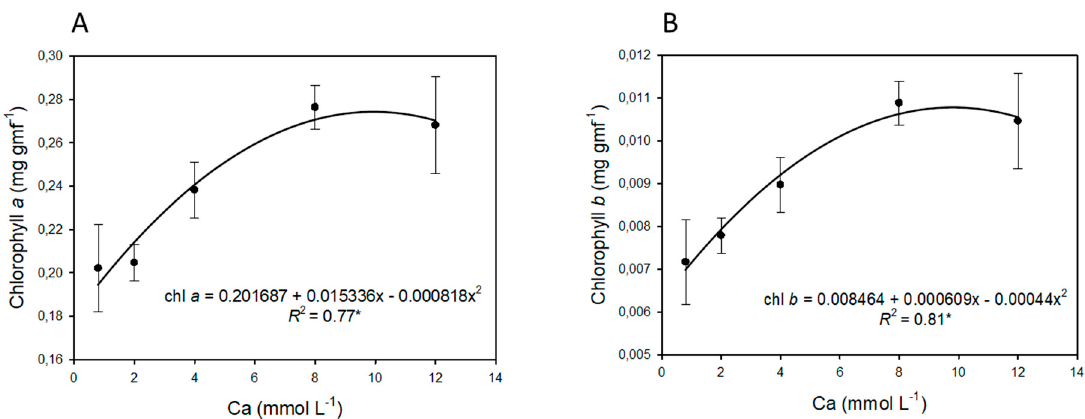
Figure 4. Contents of chlorophyll a ( A ) and b ( B ) of eucalyptus seedlings as a function of the calcium supply (mmol L − 1 ). Chl: Chlorophyll. * Significant at p ≤ 0.05. The bars represent the standard error.